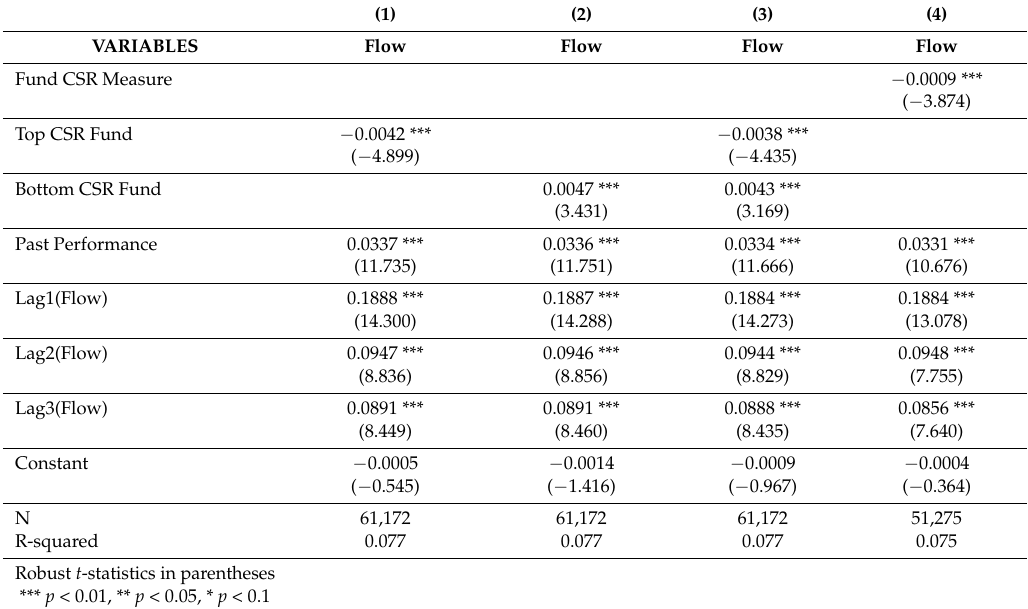
Table 2. CSR-funds and new investments: whole sample analysis